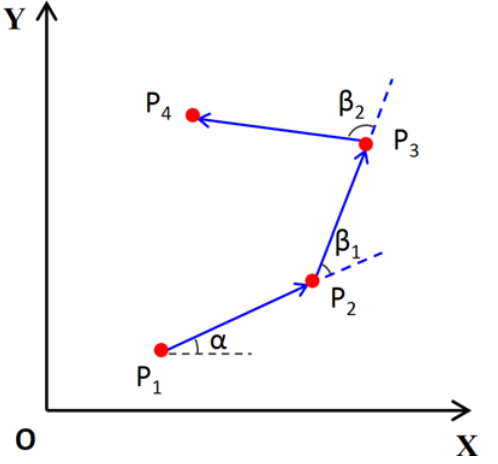
Fig 2. Direction and direction change of GPS data